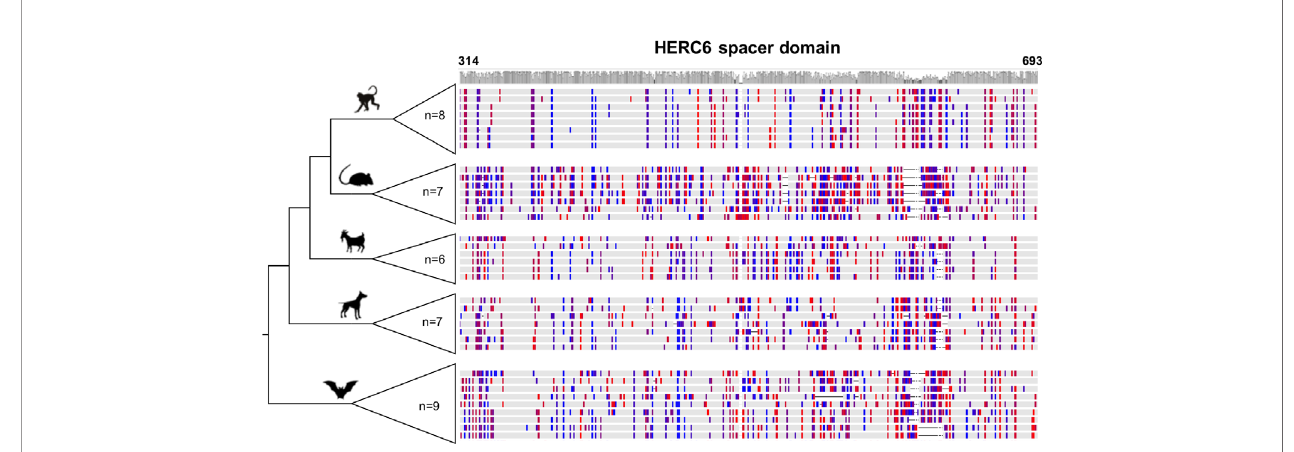
FIGURE 4 | Rapid evolution of mammalian HERC6 spacer region is characterized by multiple amino acid changes and major indels. Multiple alignment and comparison of the HERC6 spacer region between and within mammalian orders. Left, cladogram with the number of sequences used for each clade (n = 6 to 9). Right, colors indicate site variations between the sequences as compared to the consensus sequence with a threshold of 25% (Geneious, Biomatters; blue/red, hydrophilic/hydrophobic residues), while gray represents similarity with the consensus. The average pairwise percentage of identity is graphically represented above in gray. The codon numbers are based on human HERC6